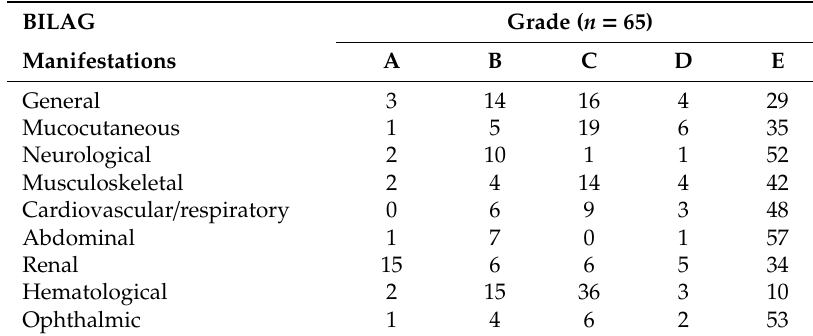
Table 2. Disease activity of SLE patients using the British Isles Lupus Assessment Group (BILAG)-2004 index.